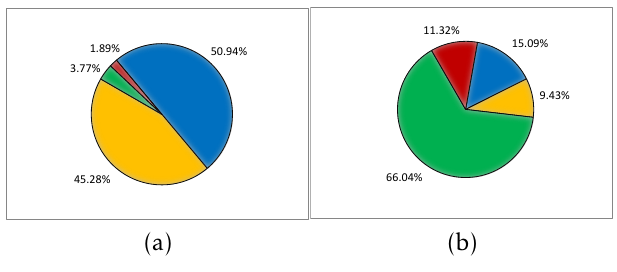
Figure 3. (a) Did you correct your project according to reviews before final